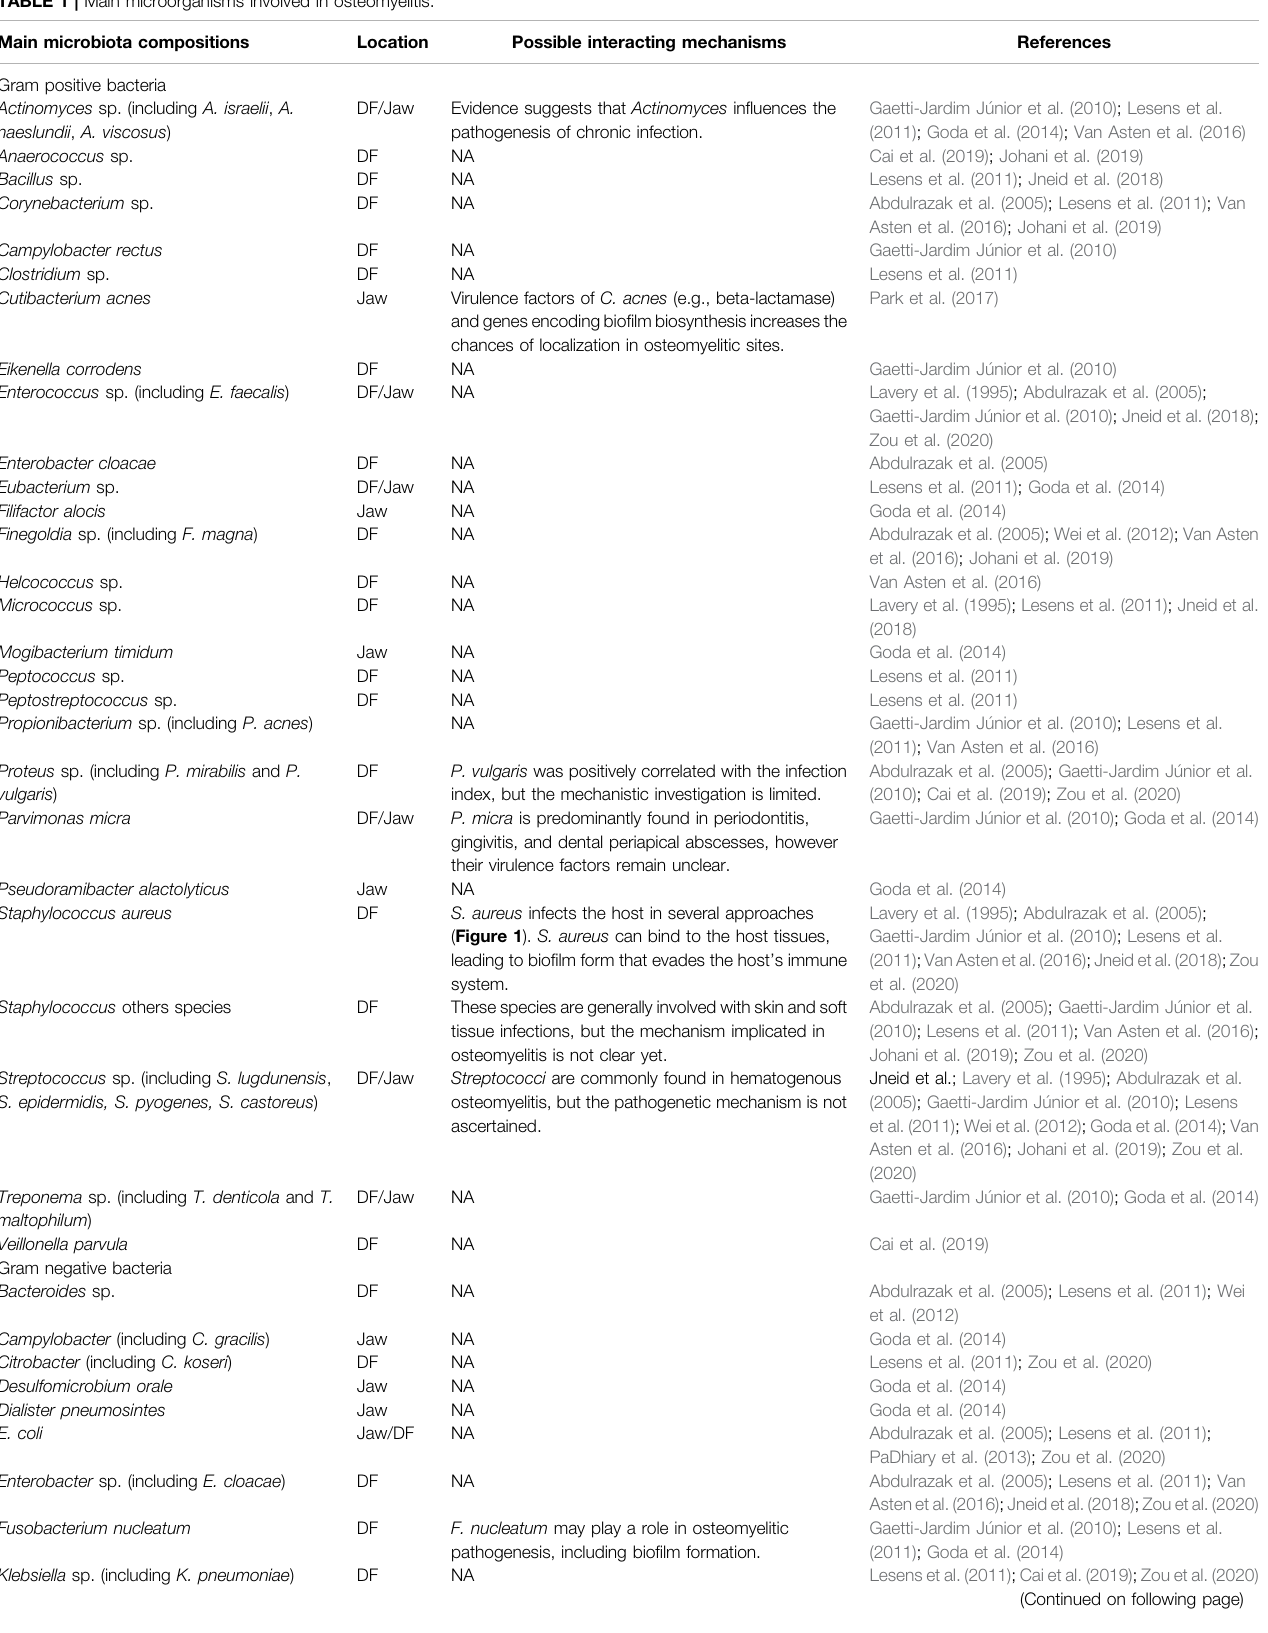
TABLE 1 | Main microorganisms involved in